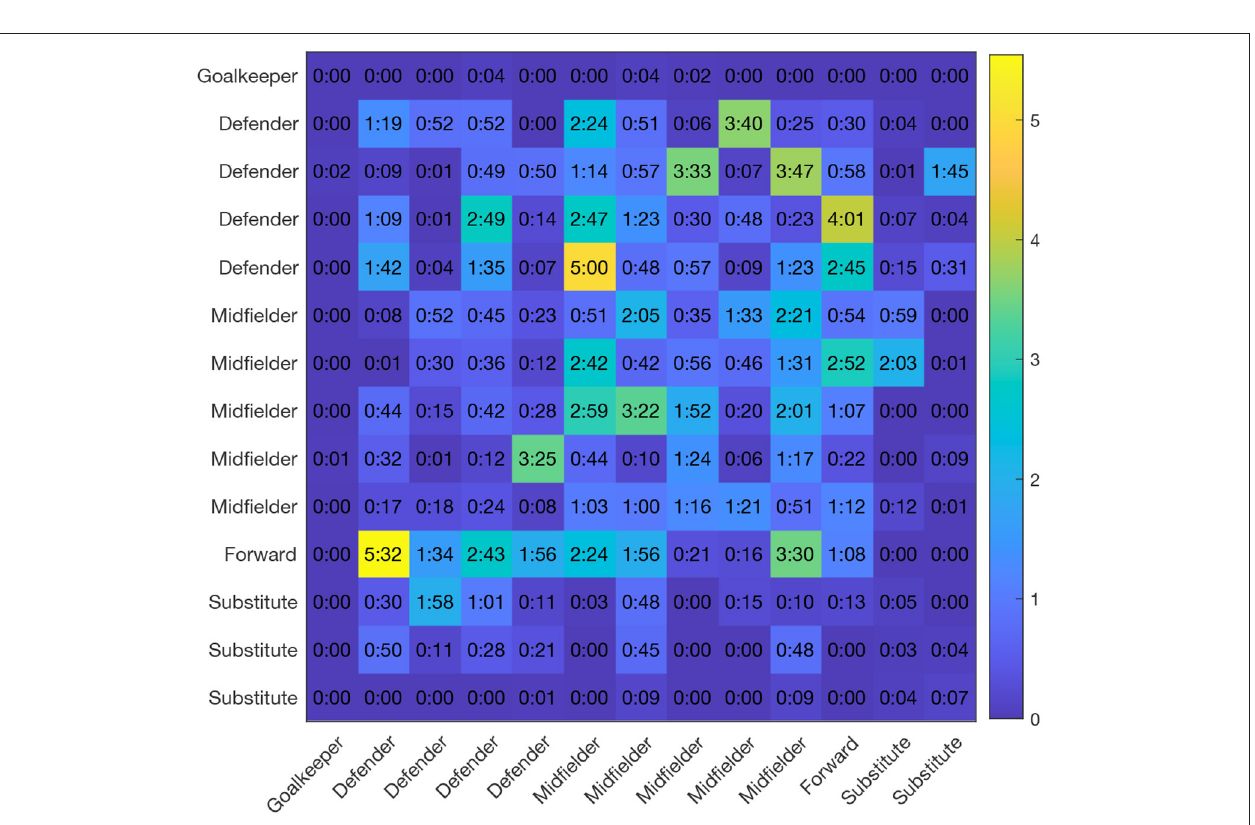
both average values being slightly higher than 1 min. The rest of the contacts are below the minutes, with the goalkeeper- have